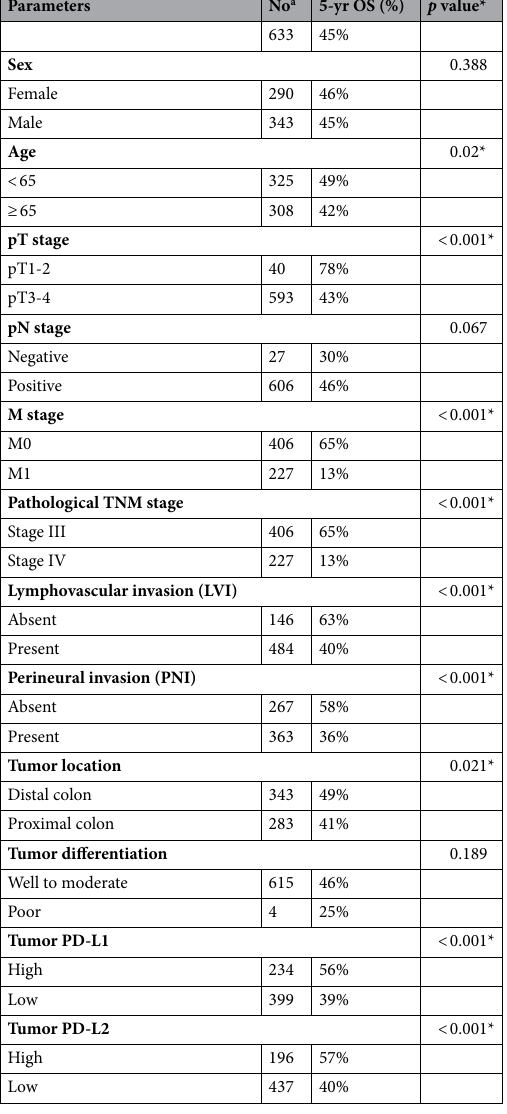
Table 3. Correlation between clinicopathologic parameters and 5-year OS (n = 633). a Number of cases may differ due to missing data. *indicated p